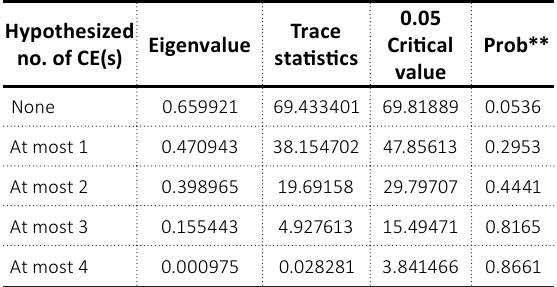
Table 5. Unrestricted cointegration rank test